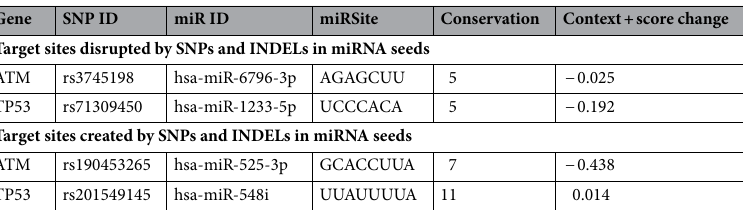
Table 3. Target sites disrupted and created by single nucleotide polymorphisms (SNPs) in miRNA seeds.